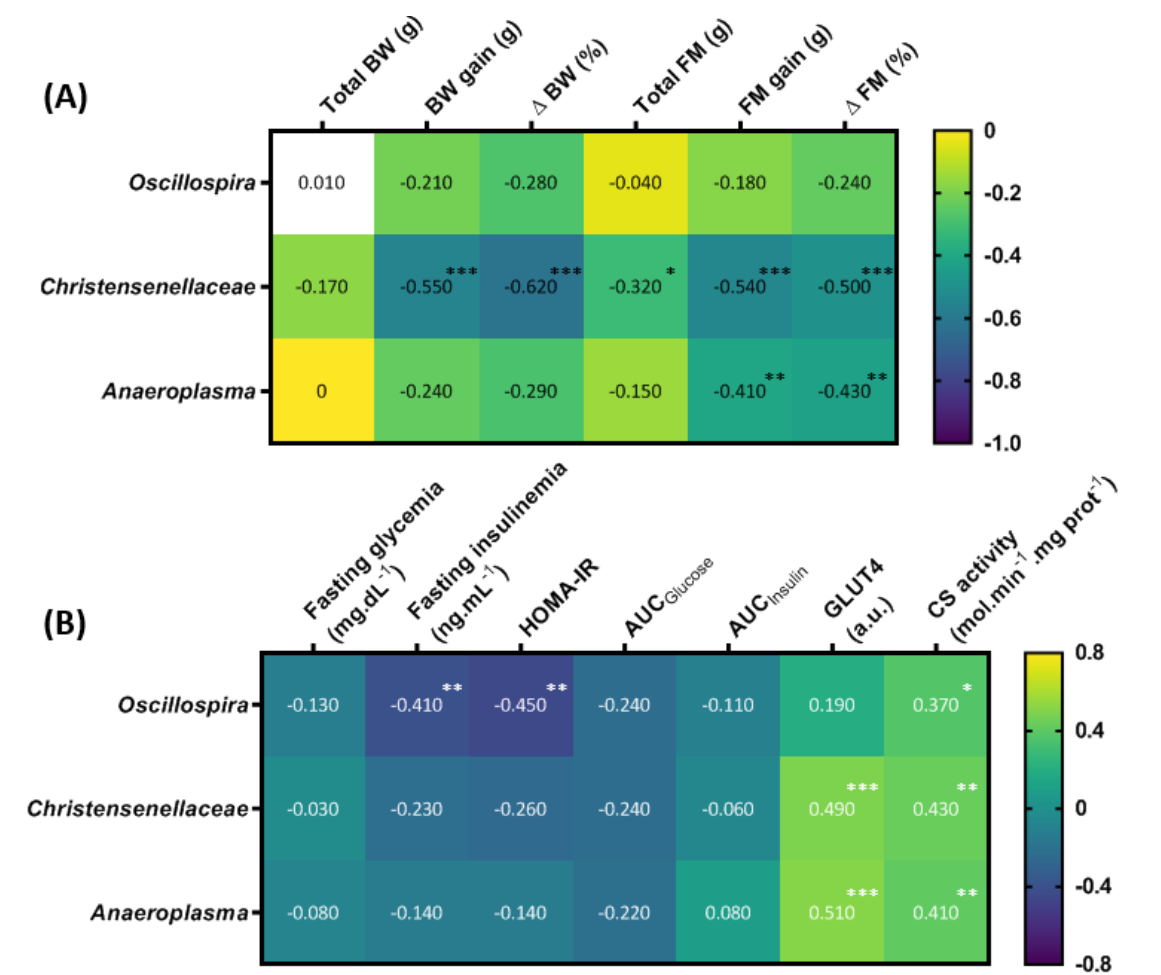
Figure 8. Taxonomy at the phylum ( A ) and family ( B ) levels for the four groups. Relative abundance (%) of specific bac- terial types in the mucosa-associated microbiota at the end of the 12-week intervention ( C – E ) * p < 0.05, ** p < 0.005, *** p < 0.0005, G: group effect.